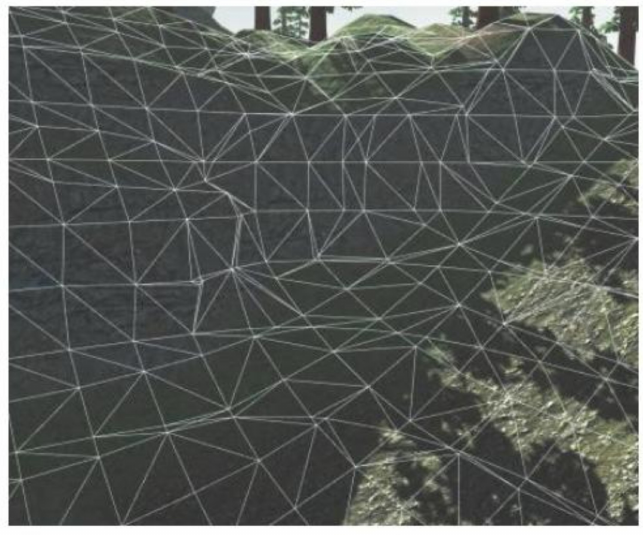
Figure 21. Polygonal mesh.